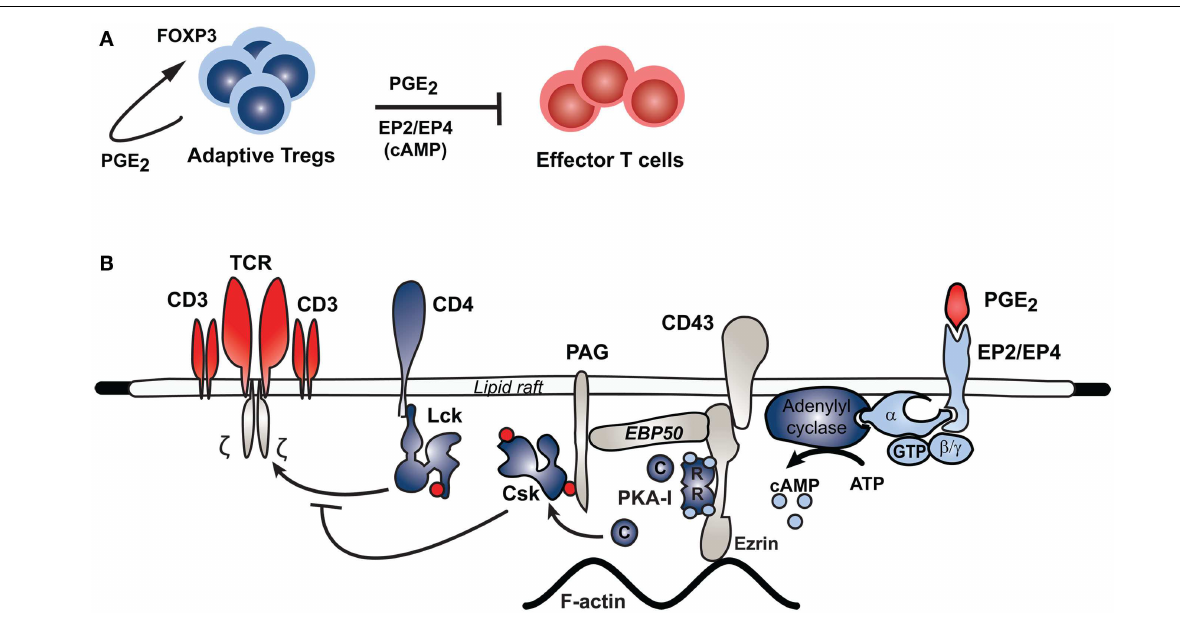
FIGURE 2 | Inhibitory pathway of PGE2 in effectorT cells . PGE 2 mediatesTreg inhibition of effectorT cell function through a PKA-mediated pathway. (A) In response to continuous antigen exposure, for instance in cancer and HIV, adaptive regulatoryT cells express COX-2 and produce PGE 2 , which stimulates FOXP3 expression in these cells. TheTreg-derived PGE 2 can signal through the EP2 and EP4 receptors on effectorT cells to inhibit the function of these cells through the pathway